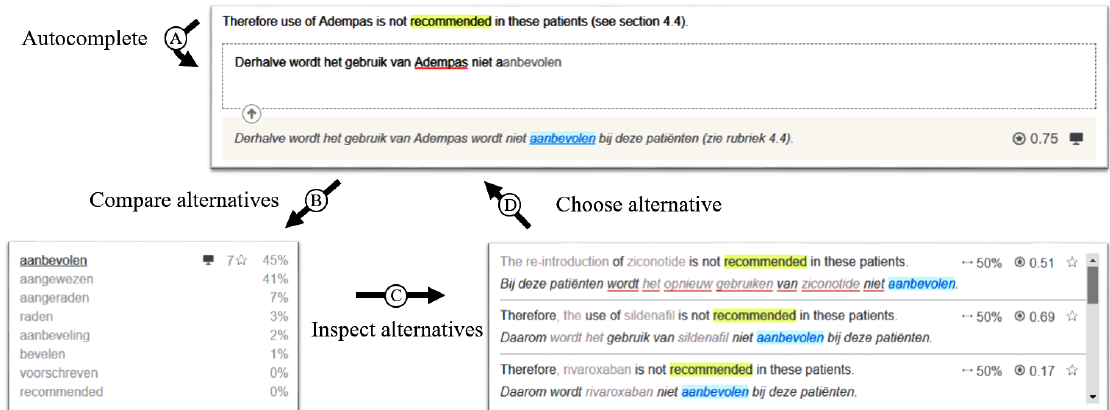
Figure 12. All translation suggestions are closely related to each other. When a translator types a character, ( A ) the auto-completion algorithm generates a suggestion. ( B ) The translator compares this prediction to other alternatives. ( C ) Interesting alternatives can be inspected in the context in which they have been used by other translators. ( D ) When a translator decides which alternative to use, it can be added to the translation by pressing